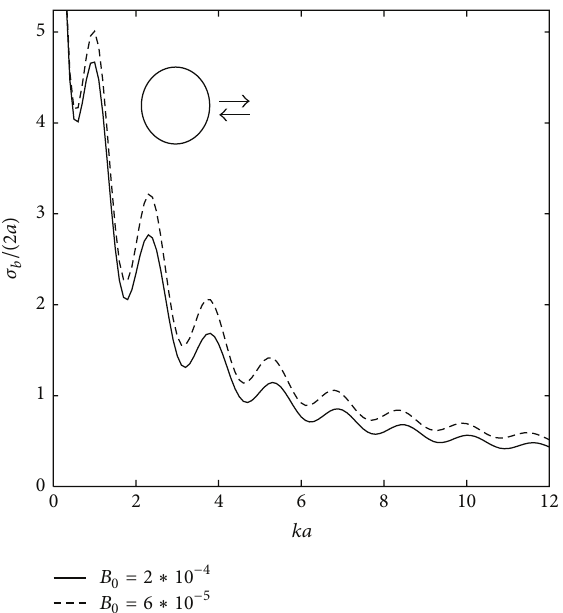
Figure 5: LRCS versus target size for 𝛿 = 0 and 𝑘𝑊 = 1.5 where the target is located in random medium with SCL = 2.2.